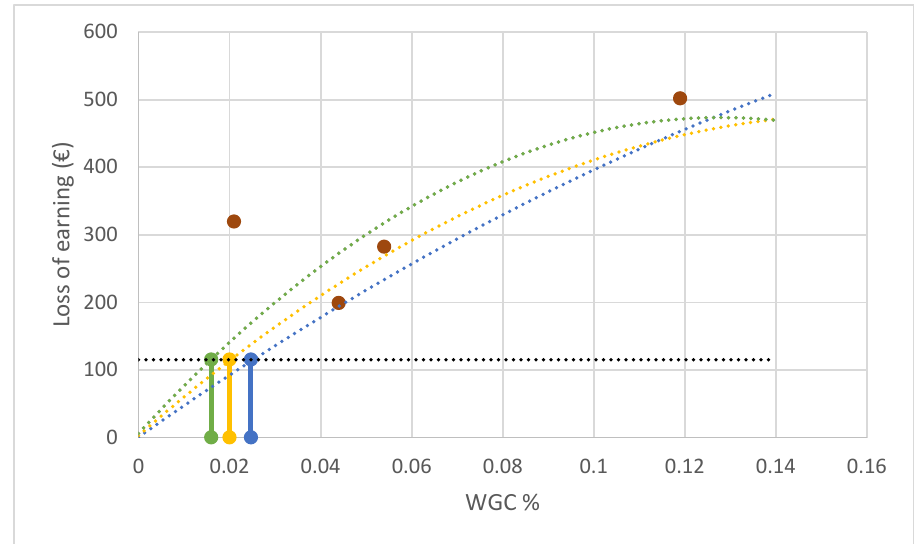
Figure 5. Determination of the economic threshold. The dotted black line represents the cost of the weeding (115.20 € ). The blue (C1), yellow (C2) and green (C3) curves represent, respectively, the damage curve obtained by using q = 2.5 and m = 0.70 (C1), q = 3.7 and m = 0.39 (C2) and q = 6.2 and m = 0.32 (C3). The threshold is identified by the intersection of the line of the weeding cost with the three curves. The points represent the observed values of WGC and RYL on the control plots (CP).